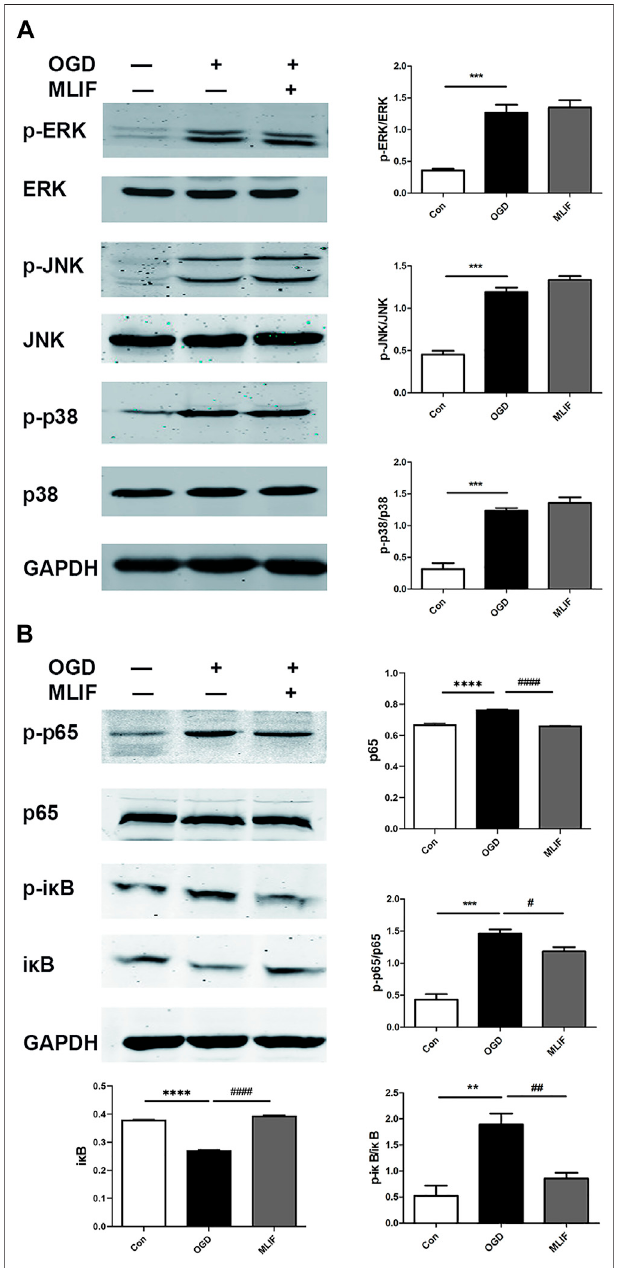
FIGURE 3 | Effect of MLIF on the MAPK pathway and the NF- κ B pathway in OGD-insulted BV2 microglia. BV2 cells were exposed to OGD for 4 h with or without MLIF (1.0 μ g/ml) incubation. (A) MAPK pathway – associated proteins p-ERK, p-JNK, and p-p38 and (B) NF- κ B pathway – associated proteins p65, p-p65, i κ B, and p-i κ B were determined by Western blot. Data are expressed as the mean ± SEM. Results were analyzed using one-way ANOVA; N (cid:1) 3. ** p < 0.01, *** p < 0.001, **** p < 0.0001, vs Control group; # p < 0.05, ## p < 0.01, #### p < 0.0001, vs OGD group.